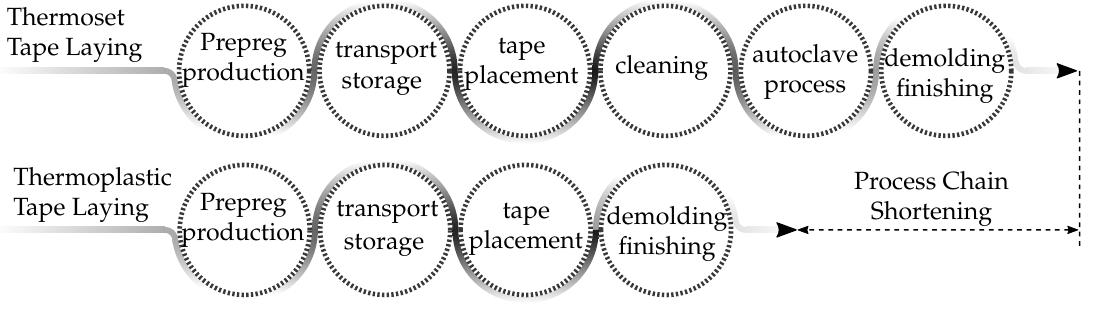
Figure 1. Process chain comparison of the thermoset and thermoplastic tape